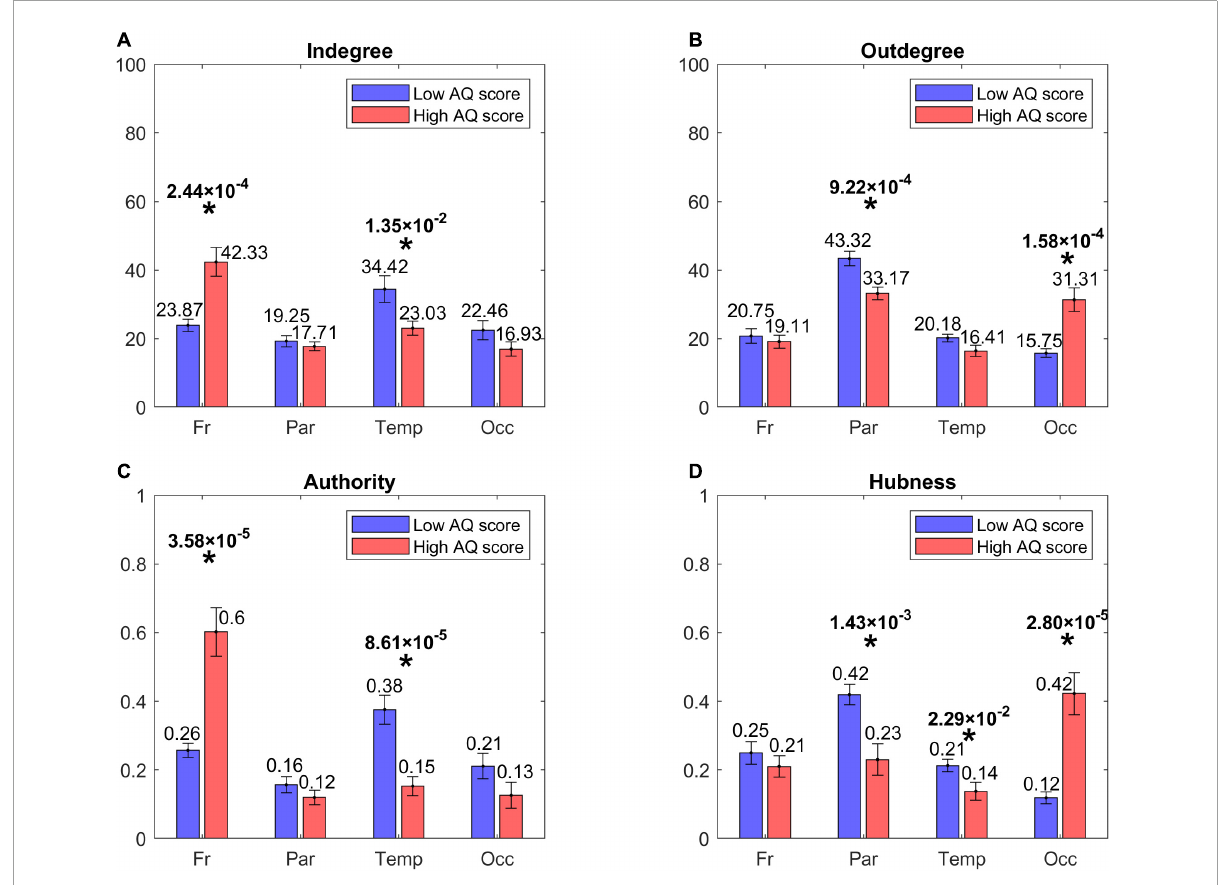
FIGURE4 Bar plots representing the centrality indices [in degree: panel (A) , out degree: panel (B) , authority: panel (C) , hubness: panel (D) ] for the four lobes of the brain, i.e., Frontal (Fr), Parietal (Par), Temporal (Temp), and Occipital (Occ) in each group of participants (red bars for the High AQ score Group, blue bars for the Low AQ score Group). Each bar shows the index value (mean ± SEM) for the specific area in the specific group of participants. As per definition, the sum of the authority values and the sum of the hubness values across all areas provide a total of 1, while the sum of the in degree values and the sum of out degree values across all areas is equal to 100. The asterisks indicate the presence of a statistically significant difference between the two groups ( p < 0.05,